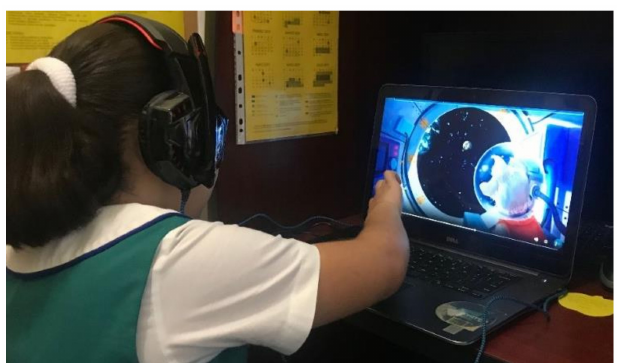
Figure 4. Participant in the HighVIDEO group puts lesson on full screen during the test.